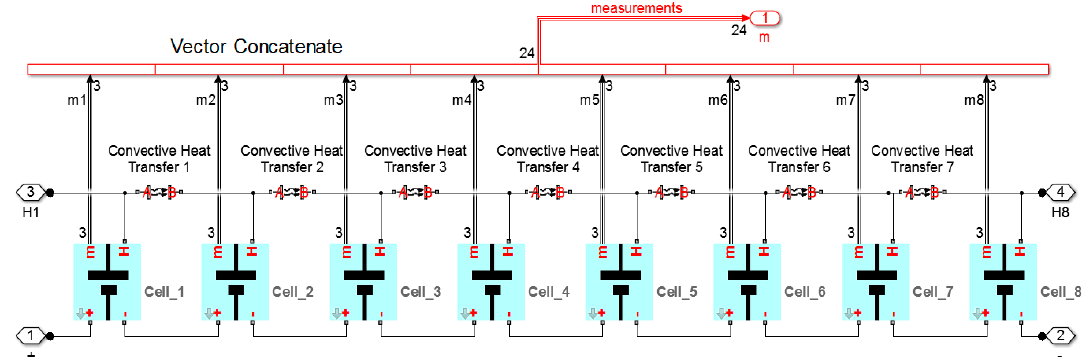
Figure 6. Eight cells connected in series to compose a stack.